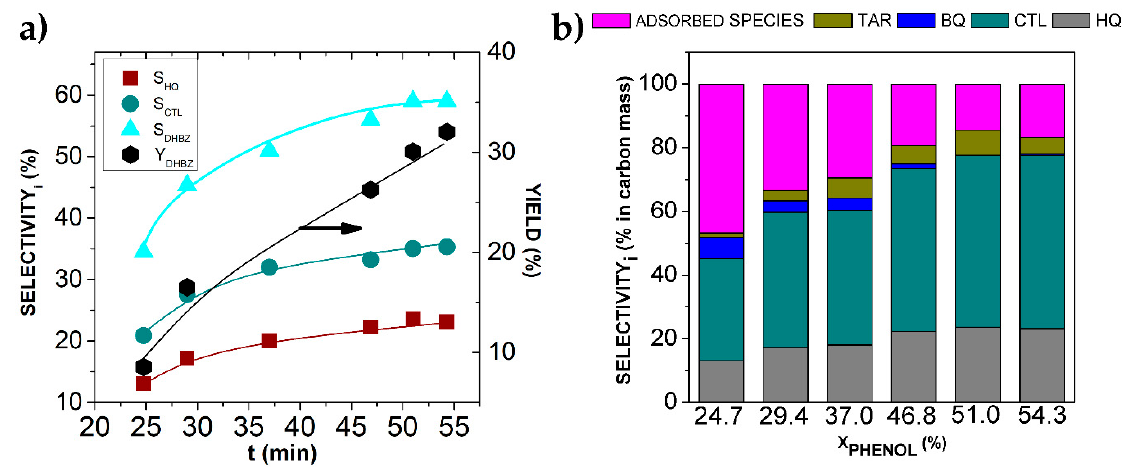
Figure 4. ( a ) Evolution of the molar selectivity and yield to DHBZ upon the hydroxylation of phenol over Fe-BTC in a batch reactor; ( b ) carbon mass distribution upon the hydroxylation of phenol over Fe-BTC. Operating conditions: [Phenol] 0 = 0.35 mol L − 1 , T = 20 °C, W FeBTC = 0.01 g.